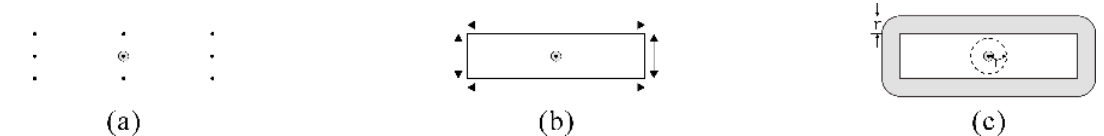
Figure 5. The search spaces schematic diagram of the three labeling models. ( a ) Fixed-position model with eight candidates; ( b ) four-slider model; ( c ) the proposed model.